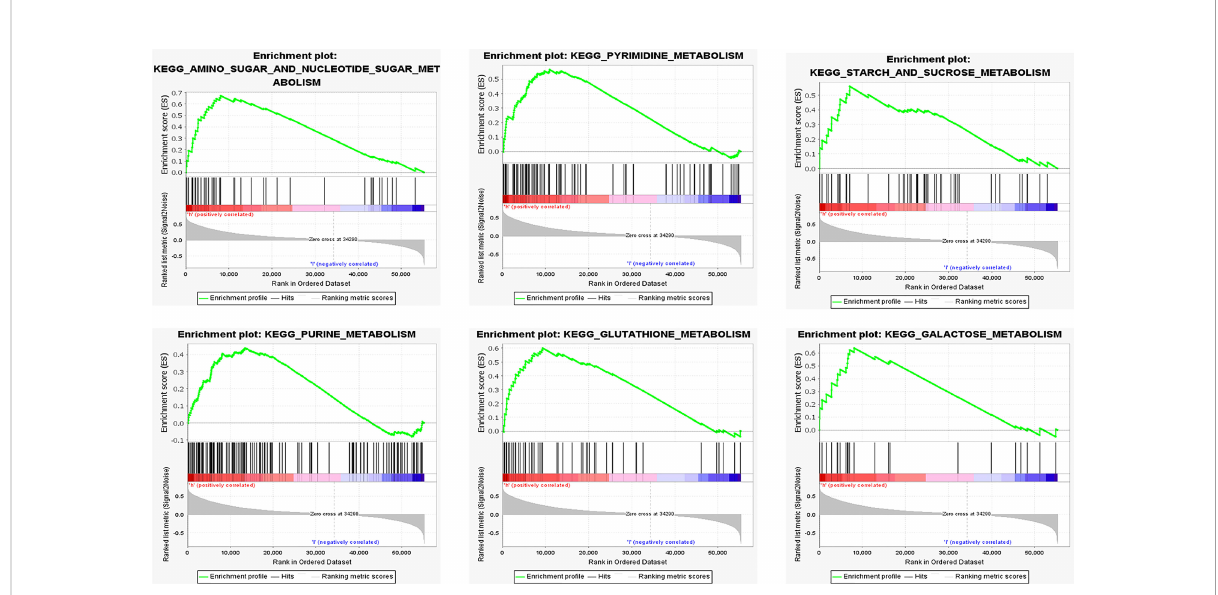
FIGURE 7 Functional enrichment analysis based on the risk model of the COL6A2 expressed by GSEA, KEGG pathways and oncogenic signatures in the high-risk group.